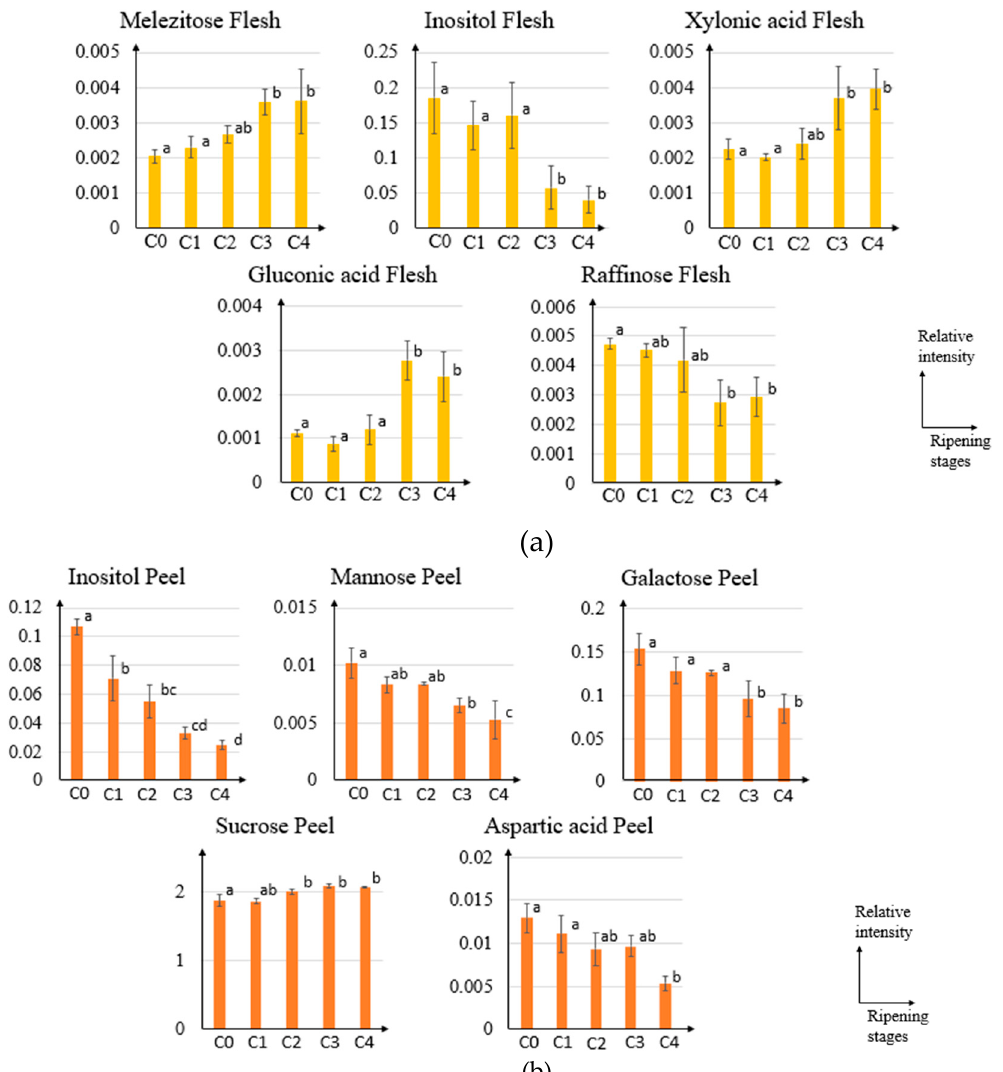
Figure 6. Bar graph of five highest variable important in projection (VIP) metabolites related to pineapple ripening process in ( a ) flesh and ( b ) peel part. The relative intensity of the five highest VIP metabolites was normalized by the internal standard. Vertical axis represents metabolites relative intensity and horizontal axis represents ripening stages. Significant differences ( p < 0.05) are indicated with the different letters based on mean comparison Tukey’s test